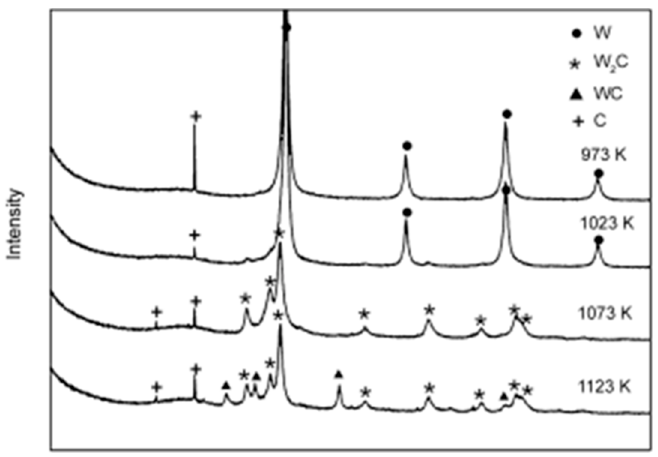
Figure 4. X-ray diffraction (XRD) patterns of 30% W 2 C/AC prepared at different carbothermal hydrogen reduction temperatures. Adapted with permission from [42]. Copyright WILEY-VCH Verlag GmbH and Co. KGaA, Weinheim, 2008.